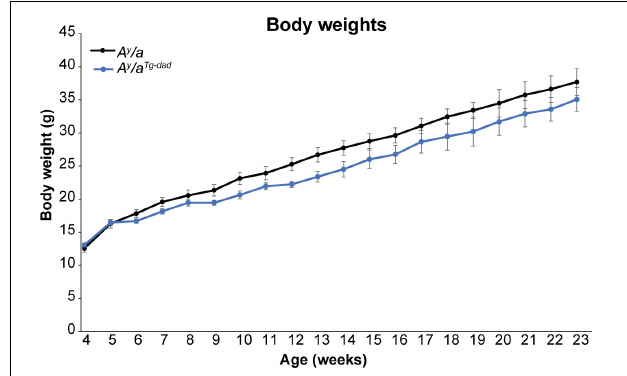
FIGURE 4 | Body weights following paternal transmission of hOGG1 . Body weights were measured at weekly intervals in female mice. Averages ± SEM. * p < 0.05 vs. A y